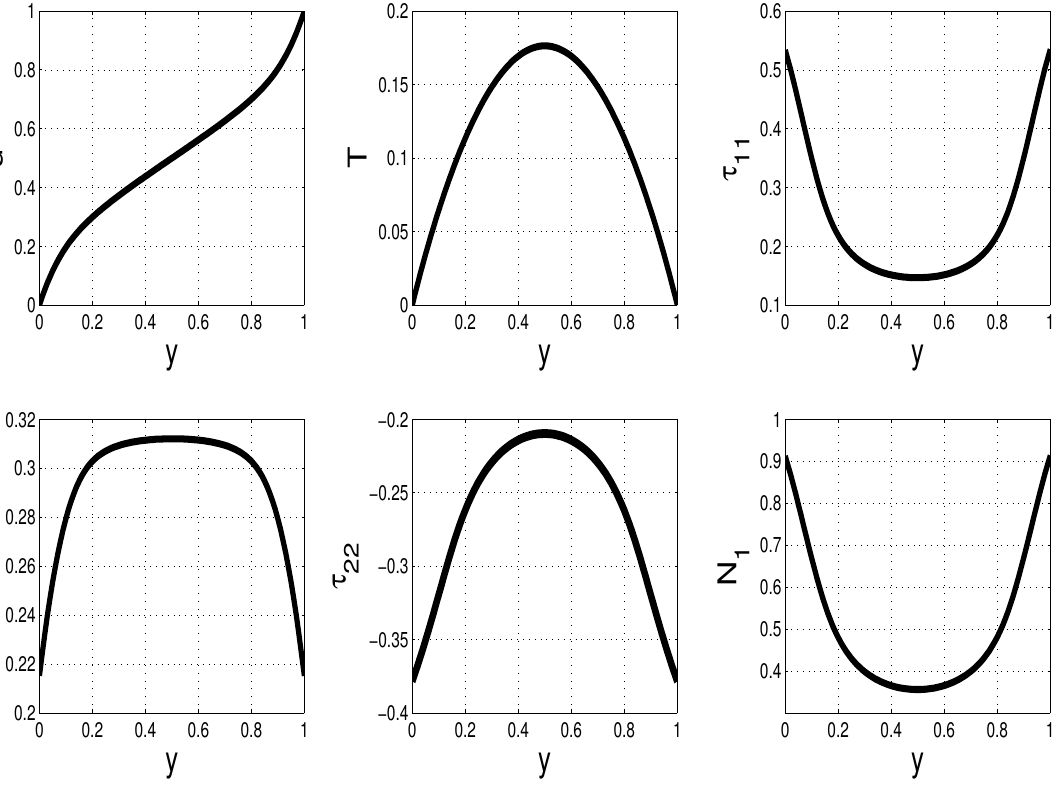
Figure 8. Development of shear bands for the Giesekus model with β = 0.95, ε = 2. The figures represent: Top-row from left to right velocity ( u ), temperature ( T ), and τ 11 -stress. Bottom-row from left to right τ 12 -stress, τ 22 -stress, and first normal stress difference ( N 1